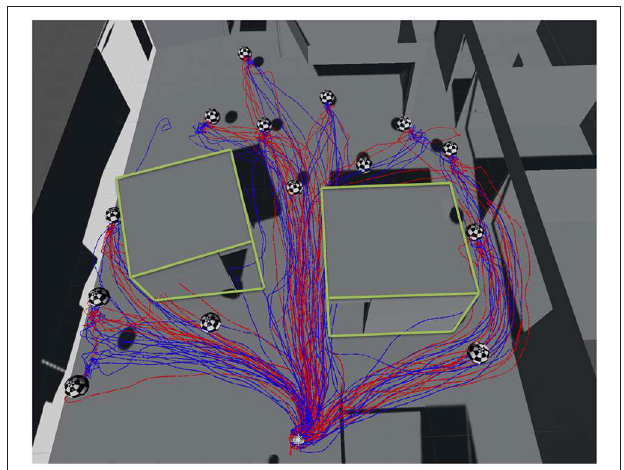
FIGURE 16 | The location of targets on the floor, and the paths of the participants, recorded during the experiment (blue: mode 1; red: mode 2). The green outlines represent the walls of two rooms present in the